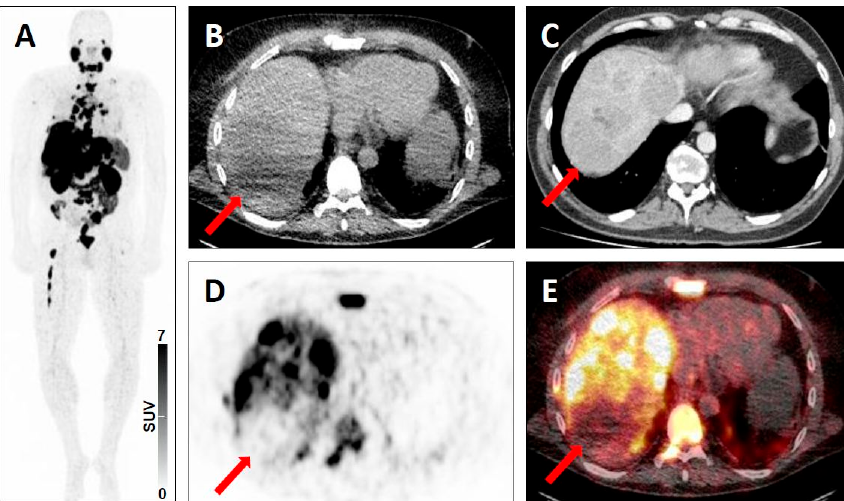
Figure 9. Lesion suggestive of malignancy on anatomic imaging but lacking uptake on PSMA-targeted positron emission tomography (PET)/computed tomography (CT). 68 Ga-PSMA-11 PET/CT for restaging in a 52-year-old man with a history of a prostate cancer. Whole-body maximum intensity projection image demonstrating intense radiotracer uptake in metastases in the liver, lymph nodes and bone ( A ). Axial low-dose CT ( B ), contrast-enhanced CT ( C ), PET ( D ), and fused PET/CT ( E ) showing a hepatic lesion suggestive of malignancy on anatomic imaging, but lacking uptake (red arrows), consistent with a PSMA-RADS-3D lesion. In addition, there are numerous hepatic lesions with intense tracer uptake, consistent with a classification as PSMA-RADS-5 lesions.